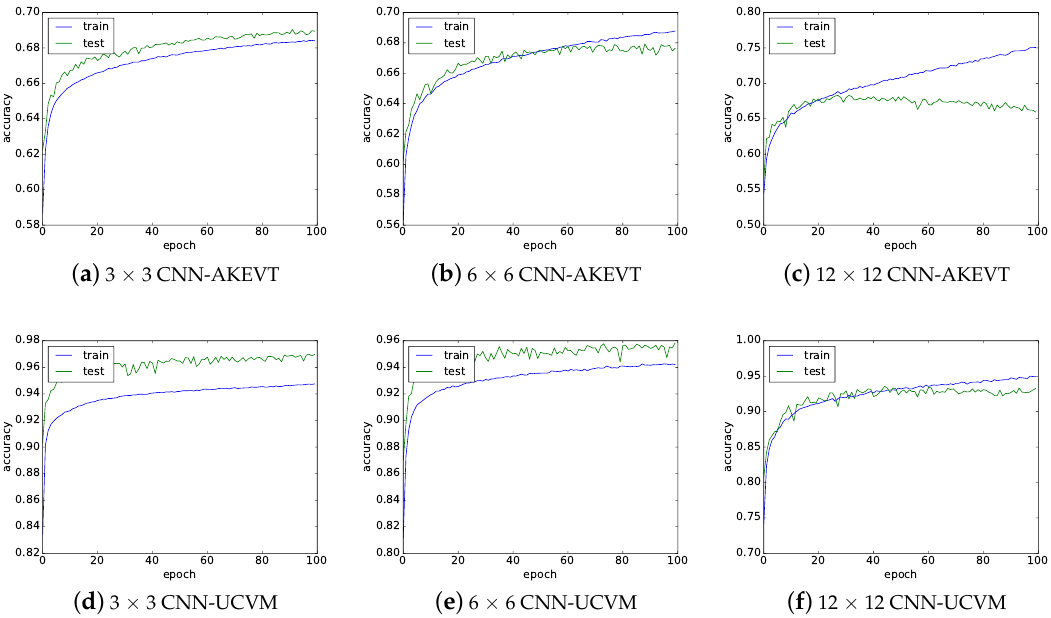
Figure 9. CNN model convergence over 100 epochs for patch size of 3 × 3, 6 × 6, and 12 × 12 when trained using AKEVT ( a – c ), and UCVM ( d – f ), where the green line indicates the test dataset and the blue line indicates the training dataset. Notice the CNN-AKEVT model overfits for the 6 × 6 and 12 × 12 image patches after certain